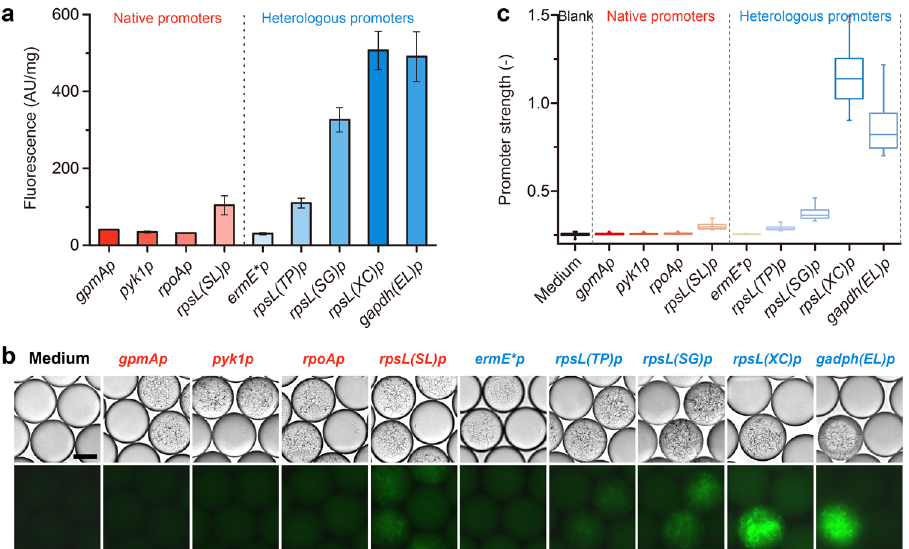
Fig. 3 Promoter characterization in S. lividans 66. a Relative strength of promoters in 24-well cultivation ( n = 3). Error bars represented the standard deviation. b Microscopic observation of nine green fl uorescence-positive stains harboring different promoters. Scale bar: 5 μ m. The exposure time was 100 ms. c Relative strength of promoters in droplets observed using a ×10 objective in FADS analysis using at least 175 droplets for each sample. Error bars represented the minimum and maximum values.